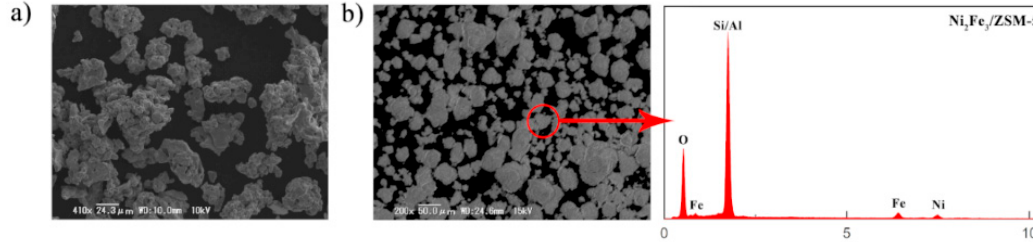
Figure 2. SEM images of ( a ) Ni 2 Fe 3 catalyst particles and the ( b ) Ni 2 Fe 3 /ZSM-5 supported catalyst (including the energy-dispersive X-ray spectroscopy (EDS) spectrum).